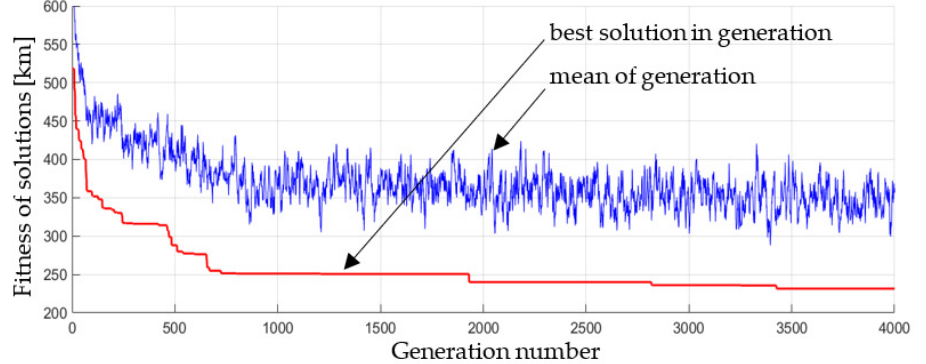
Figure 5. History of the evolution of the adaptation function during the optimization for the first scenario.